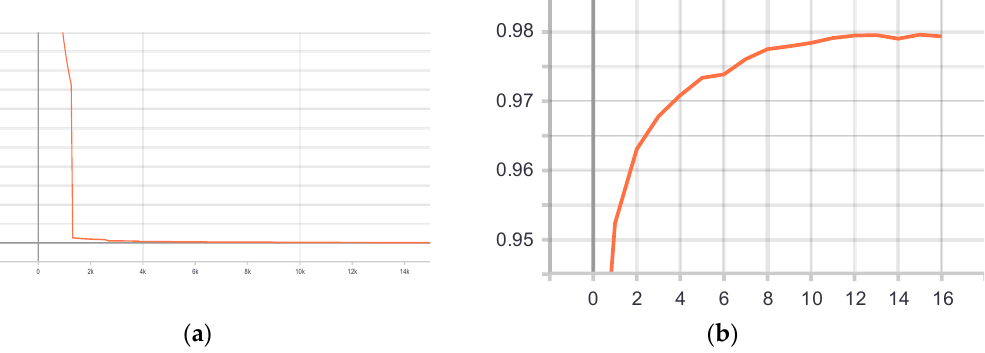
( b ) Figure 10. Data for CRNN training: ( a ) dictionary of characters and ( b ) index corresponding to image.